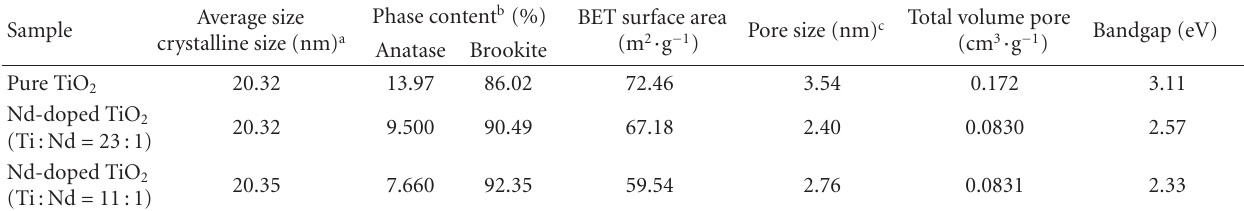
Table 1: Summary of the physicochemical properties of TiO 2 and Nd-doped TiO 2 composites.